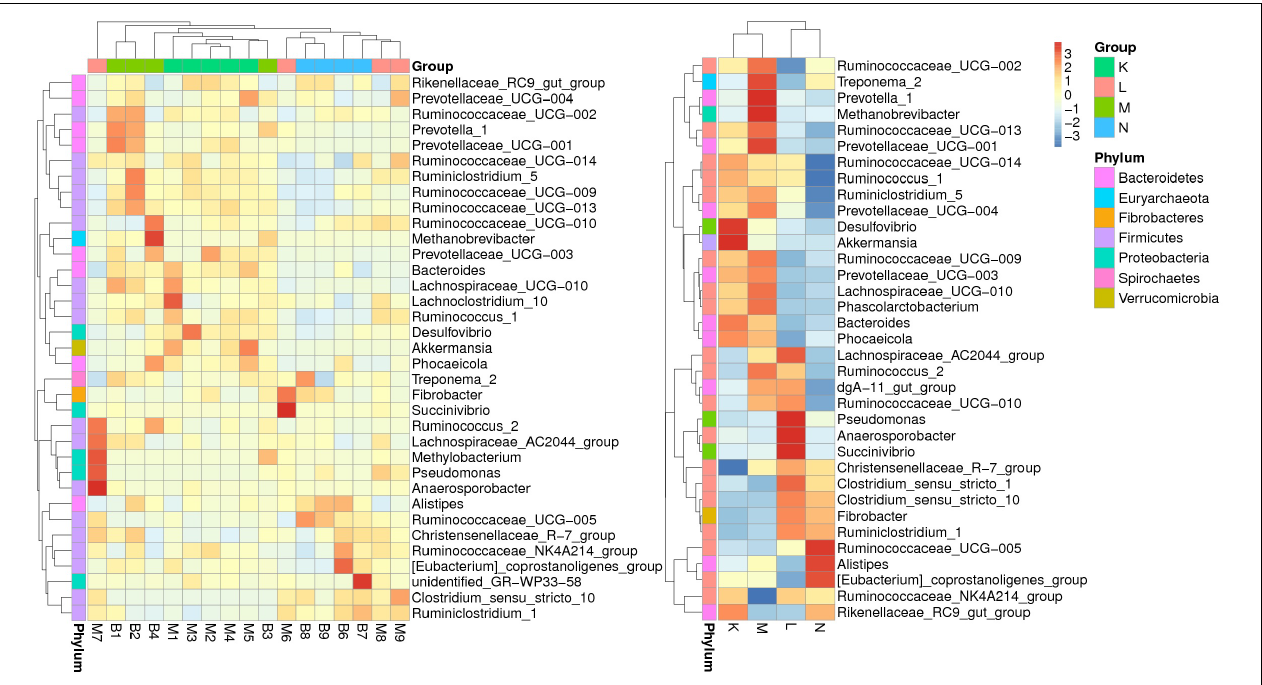
FIGURE 3 | A heatmap of species abundance clustering. The heatmap shows the hierarchical clustering of samples based on the relative abundance of the top ranked 35 genera of fecal microbiota in of European mouflon and blue sheep. The relative values in the heatmap (after normalization), depicted by colors, indicate the aggregation degree or content of bacterial species among samples at the genus level. The relative values were normalized in four individual groups and displayed in figure on the right-hand side. K, low-altitude mouflon; L, high-altitude mouflon; M, low-altitude blue sheep; N, high-altitude blue